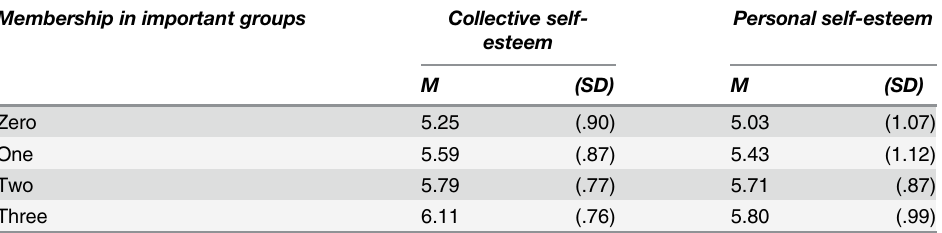
Note . Numbers in parentheses are standard deviations.